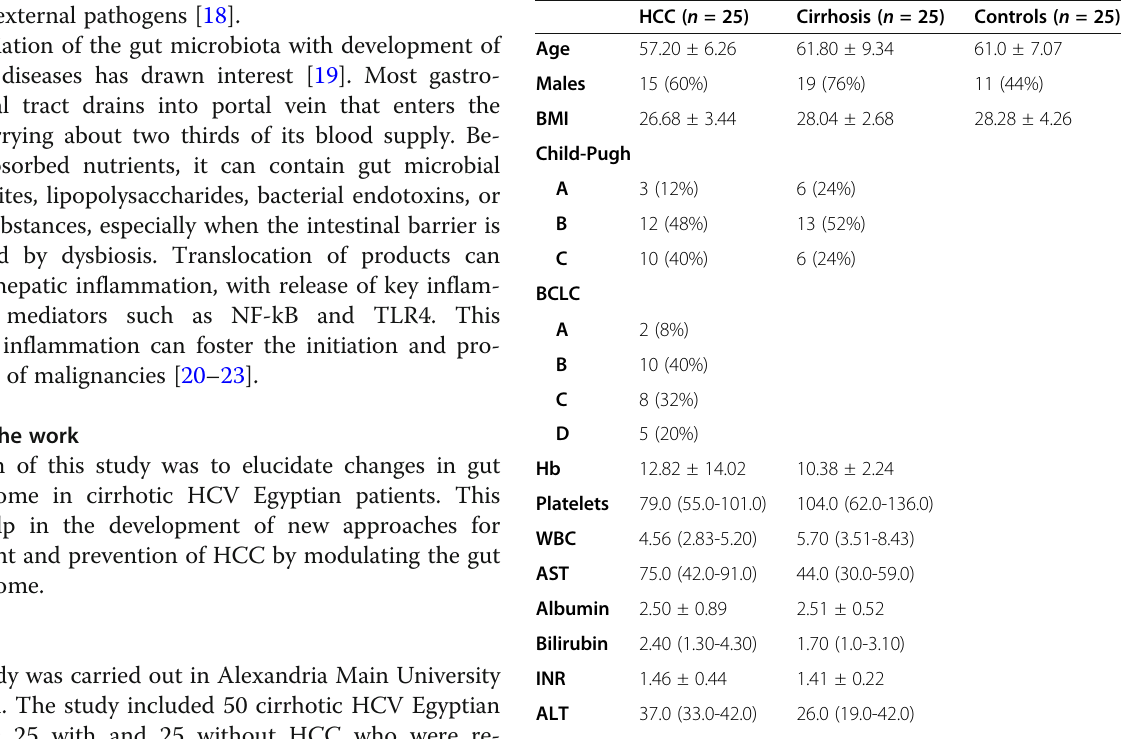
Table 1 Demographic, clinical, and laboratory characteristics of